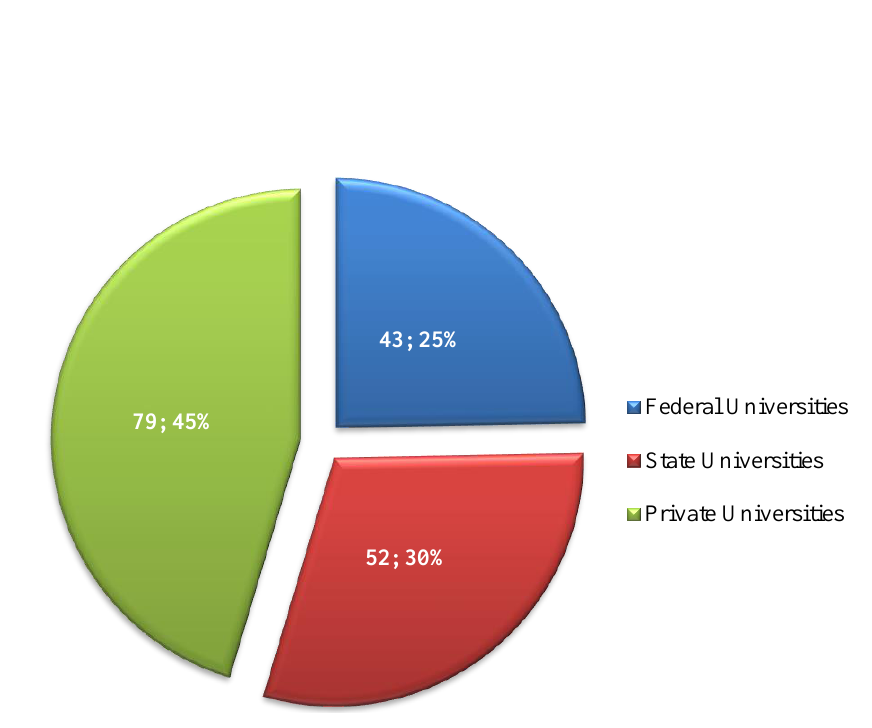
Fig. 1. The distribution of the Universities in Nigeria: the federal universities 25 %; the state universities 30 %; the private universities 45 % (developed by the authors, data adapted from the National Universities Commission, 2019).